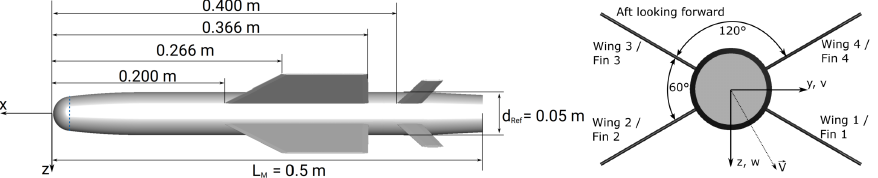
Figure 1. LK6E2 model geometry and axes definition (Adapted with permission from Ref. [6]. Copyright ©2022 by German Aerospace